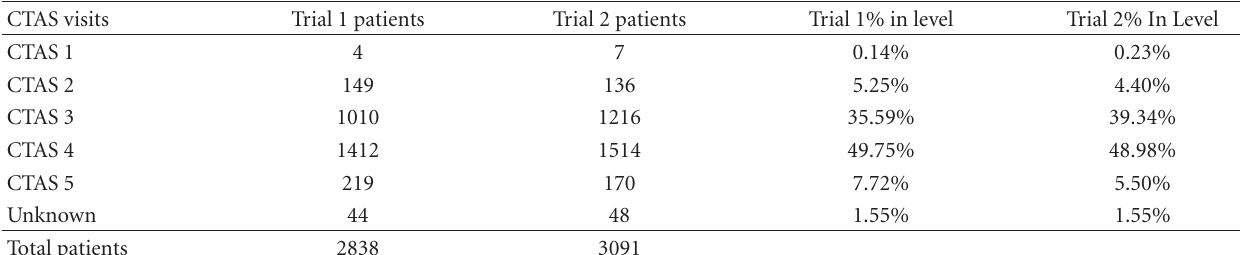
Table 1: Patient visits by Canadian Triage and Acuity Scale (CTAS)